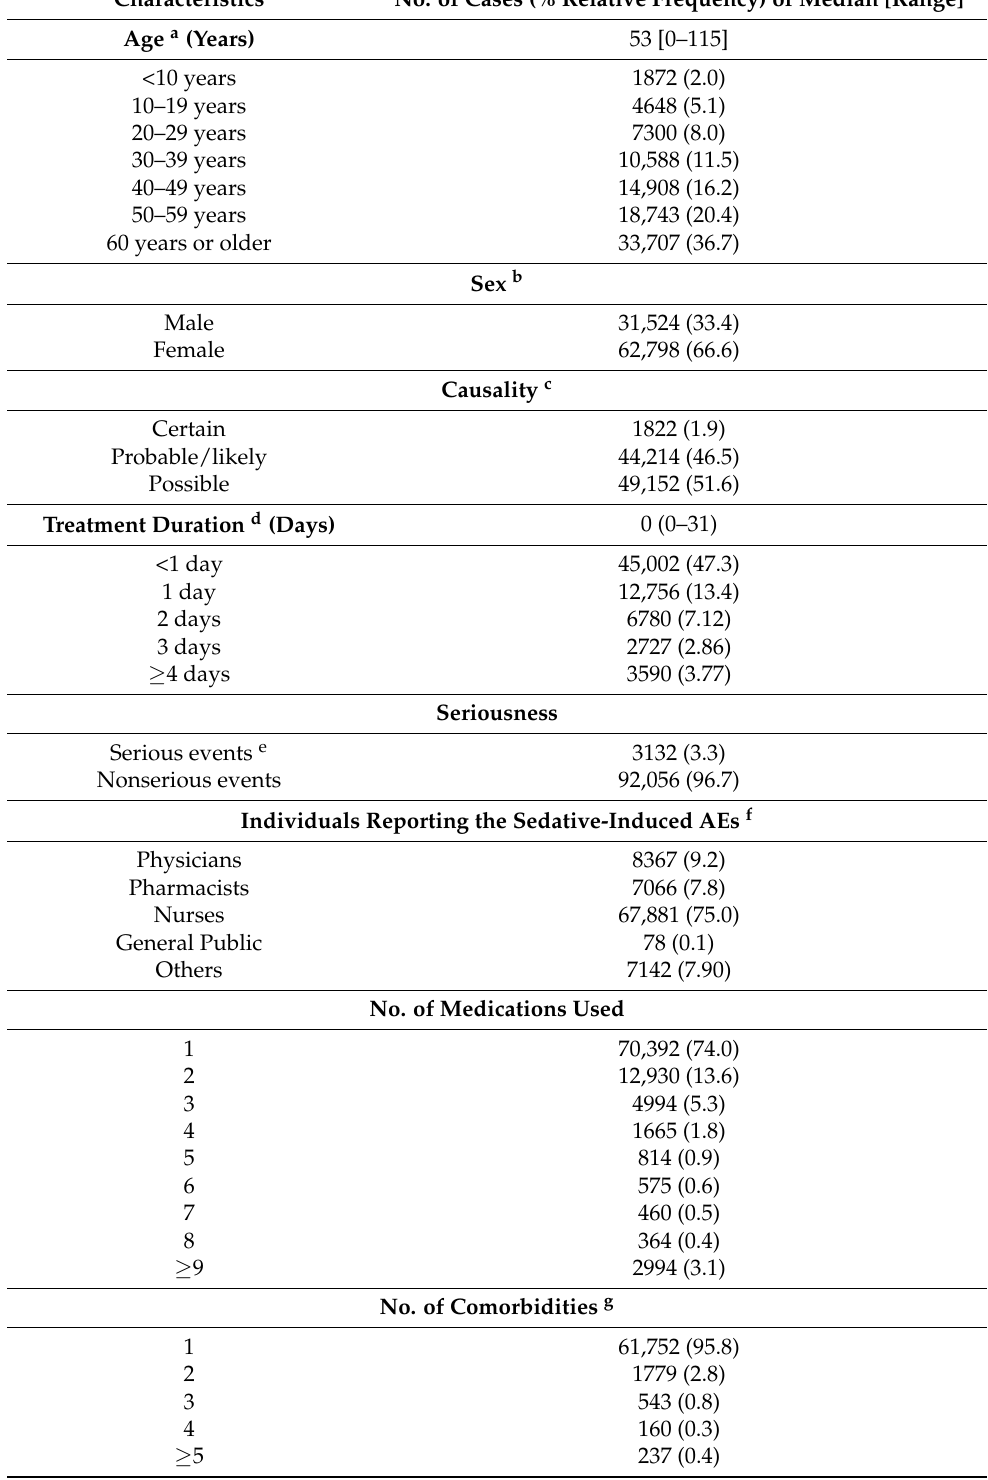
Table 2. Baseline demographic characteristics of patients from whom adverse events (AEs) caused by sedatives were reported to the KAERS (n =